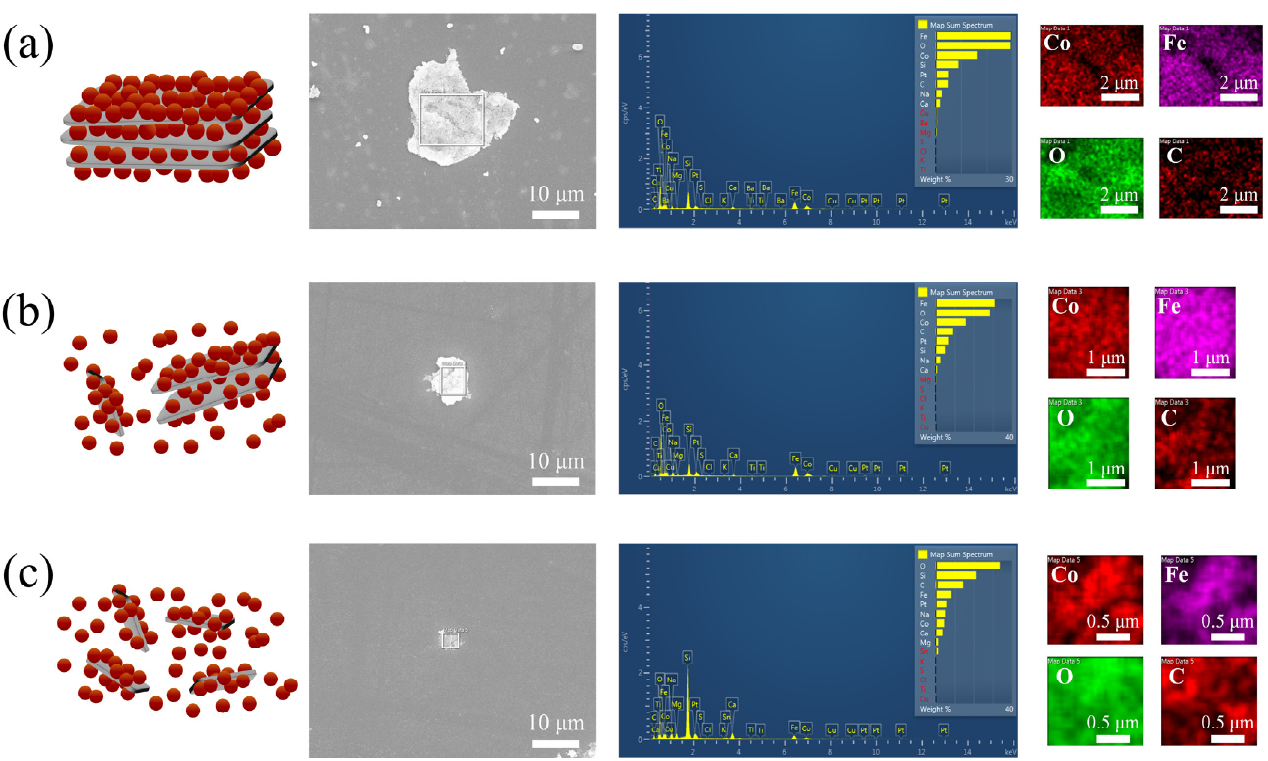
Figure 5. Schematic illustrations, representative SEM images, and EDX analysis of the 2D magnetostrictive fillers of ( a ) CFO-i-LGO, ( b ) CFO-i-MGO, and ( c ) CFO-i-SGO.